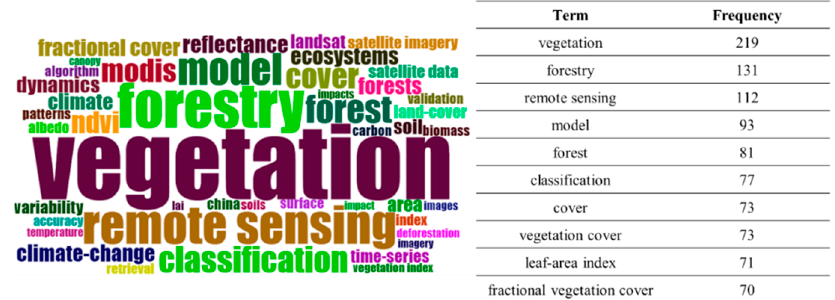
Figure 7. Frequently author’s keywords from Word Cloud.